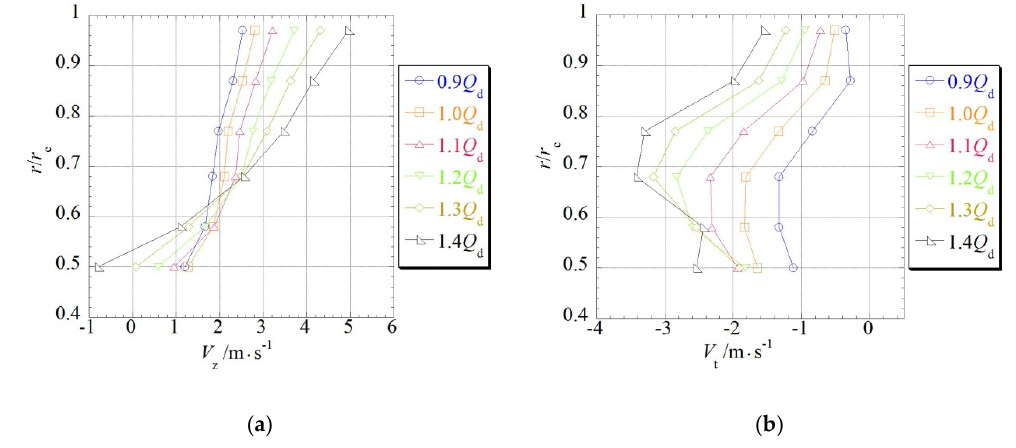
Figure 11. The rear rotor axial velocity and circumferential velocity of new model: ( a ) Axial velocity; ( b ) Circumferential velocity.